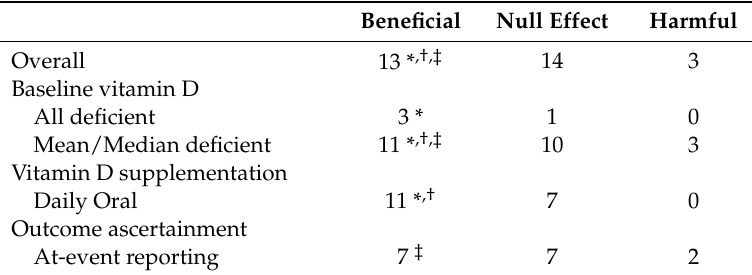
Table 2. Trial findings by trial